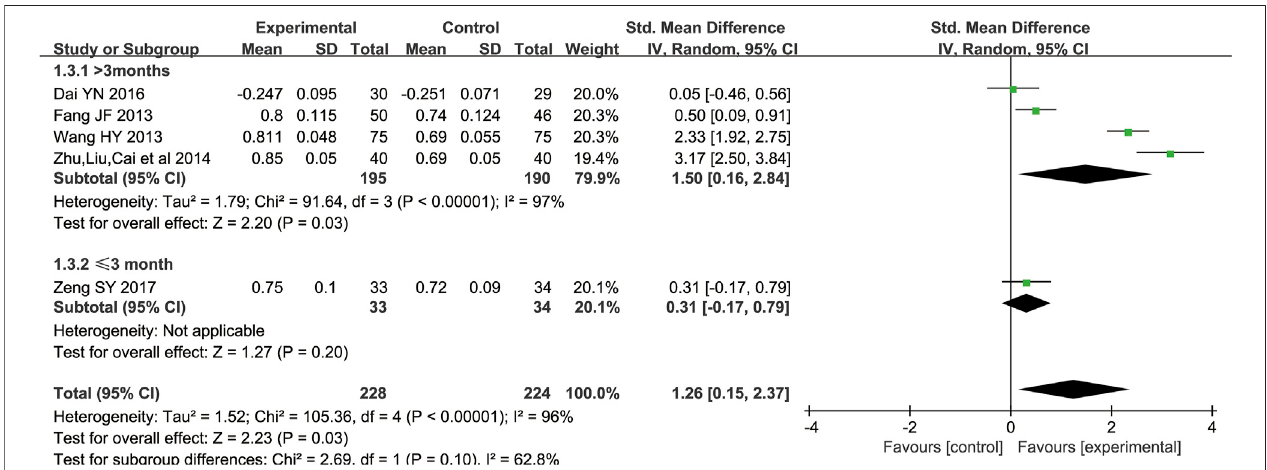
FIGURE 7 | Subgroup analyses for Epimedium as an adjuvant on the duration of the intervention.